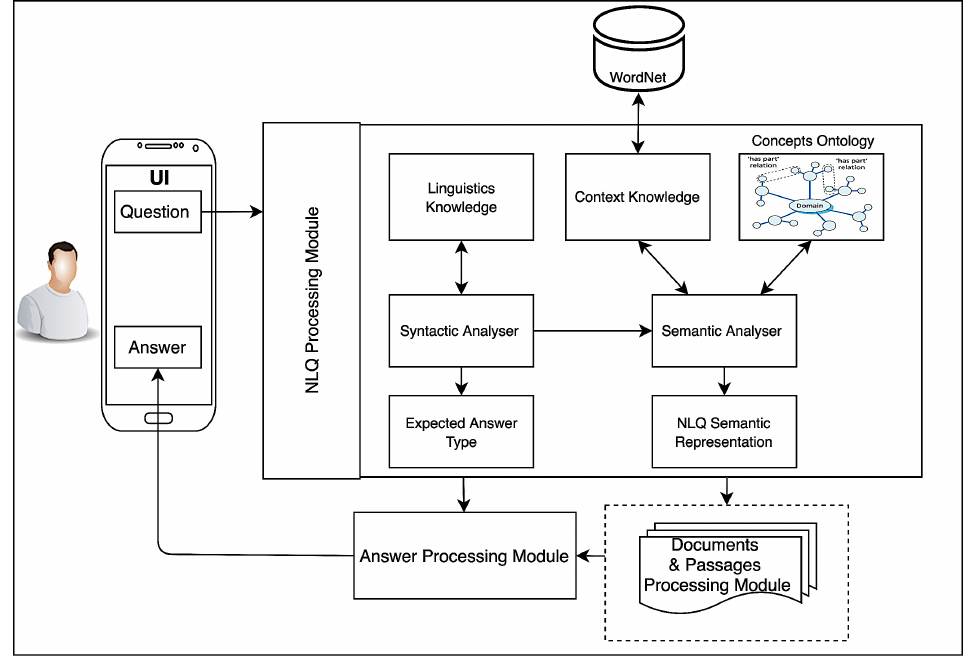
Figure 3. The architecture of the QA system based on